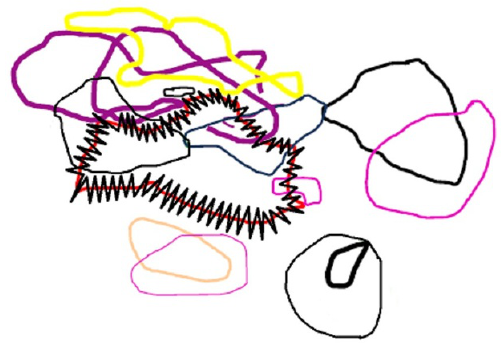
Figure 7 . The whole set of all the right or left mover derivatives are symbolized by the thin-curved network. They can be interpreted as uni(cid:12)cation of a series of closed cycles that close each